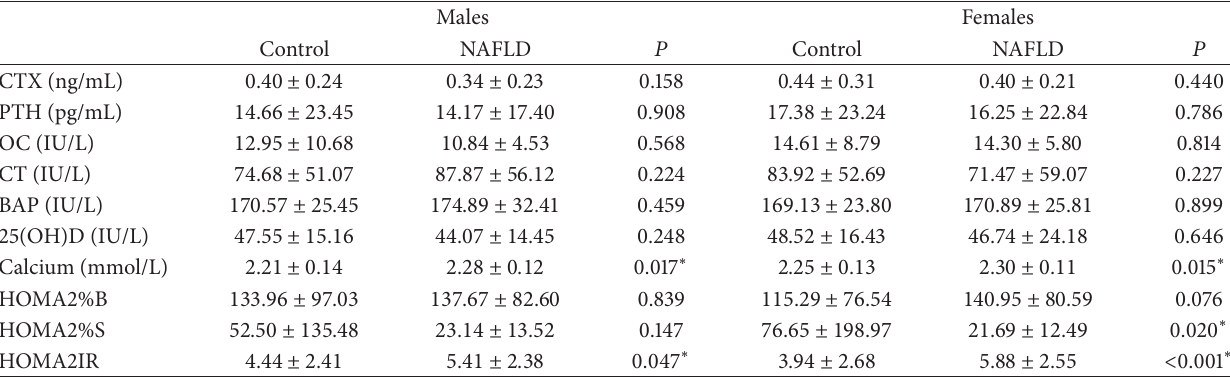
Table 3: Influence of variables on BMD in different groups.